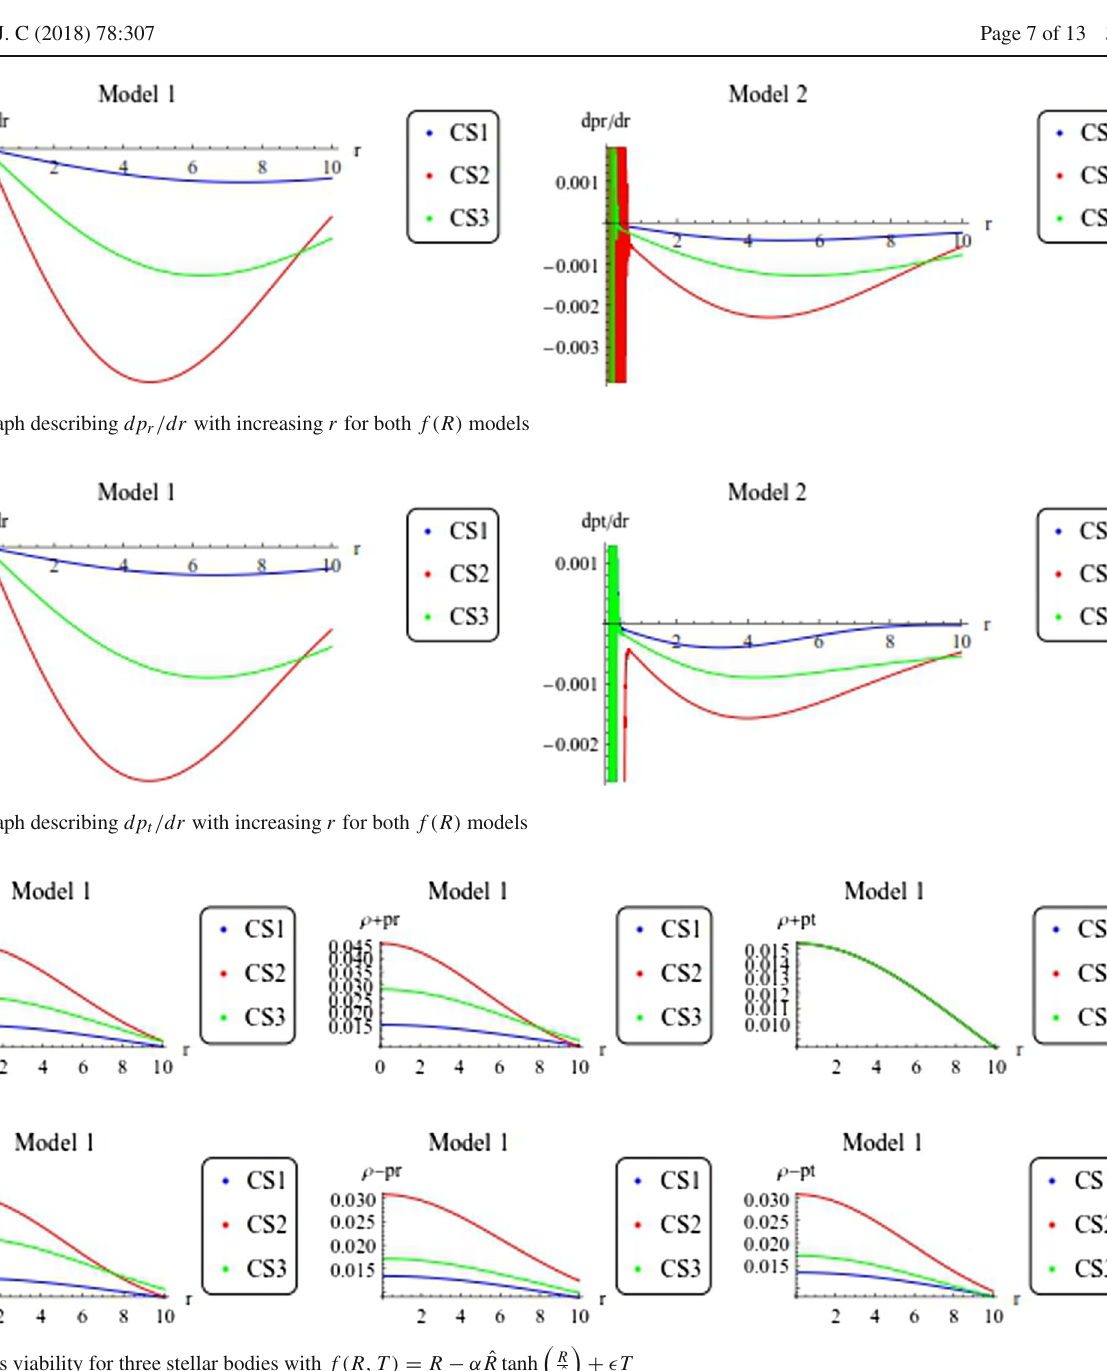
Fig. 7 ECs viability for three stellar bodies with f ( R , T ) = R − α ˆ R tanh